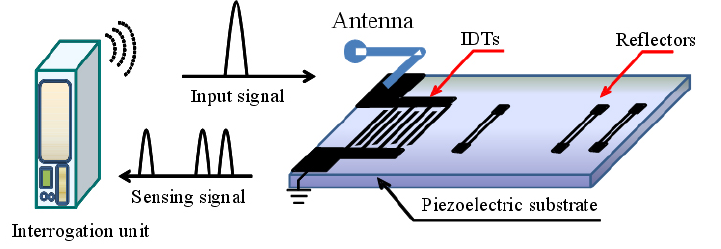
Figure 1. The working principle of the wireless sensor based on SAW reflective delay